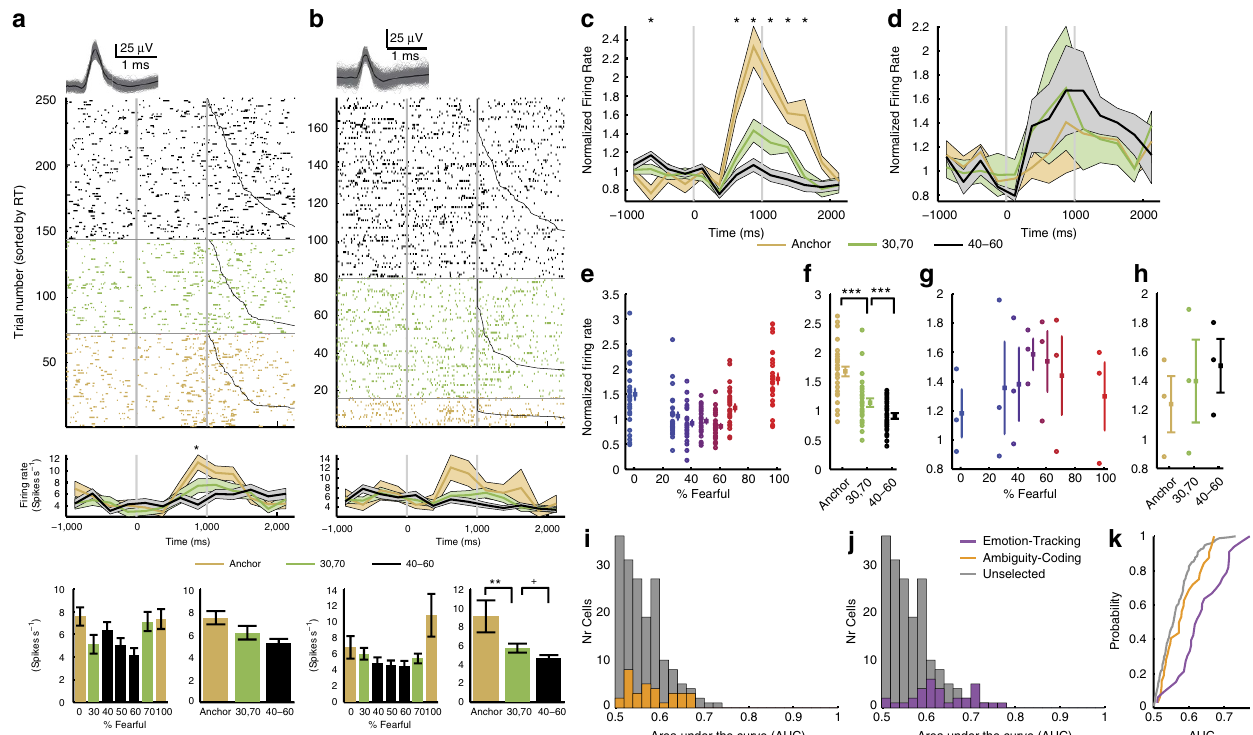
Figure 4 | Ambiguity-coding neurons. ( a , b ) Two example neurons that fire most to the anchors and least to the most ambiguous stimuli (linear regression: P o 0.05). Each raster (top), PSTH (middle) and average firing rate (bottom) is colour coded according to ambiguity levels as indicated. Trials are aligned to face stimulus onset (left grey bar, fixed 1s duration) and sorted by RT (black line). PSTH bin size is 250ms. Shaded area and error bars denote ± s.e.m. across trials. Asterisk indicates a significant difference between the conditions in that bin ( P o 0.05, one-way ANOVA, Bonferroni-corrected). Bottom left shows the average firing rate for each morph level 250- to 1,750-ms post-stimulus-onset. Bottom right shows the average firing rate for each ambiguity level 250- to 1,750-ms post-stimulus onset. Asterisks indicate significant difference between levels of ambiguity using unpaired two-tailed t -test. ** P o 0.01 and þ : P o 0.1. Waveforms for each unit are shown at the top of the raster plot. ( c , d ) Average normalized firing rate of ambiguity-coding neurons that increased ( n ¼ 29) and decreased ( n ¼ 3) their firing rate for the least ambiguous faces, respectively. Asterisk indicates a significant difference between the conditions in that bin ( P o 0.05, one-way ANOVA, Bonferroni-corrected). ( e , f ) Mean normalized firing rate at each morph level ( e ) and ambiguity level ( f ) for 29 units that increased their spike rate for less ambiguous faces. ( g , h ) Mean normalized firing rate at each morph level ( g ) and ambiguity level ( h ) for 3 units that increased their spike rate for more ambiguous faces. Normalized firing rate for each unit (left) and mean ± s.e.m. across units (right) are shown at each level. Asterisks indicate significant difference between conditions using paired two-tailed t -test. *** P o 0.001. ( i ) Histogram of AUC values for ambiguity-coding neurons (orange) and unselected neurons that are neither ambiguity coding nor emotion tracking (grey). ( j ) Histogram of AUC values for emotion-tracking neurons (purple) and unselected neurons that are neither ambiguity coding nor emotion tracking (grey). ( k ) Cumulative distribution of the AUC values. ( i – k ) Ambiguity-coding neurons did not differentiate fearful versus happy emotions with anchor faces (similar AUC values as unselected neurons) but emotion-coding neurons did (greater AUC values than unselected We refer to this group of cells as ambiguity-coding neurons. Neurons with higher firing rate for less ambiguous faces had a U-shaped response curve as a function of morph levels (Fig. 4c,e) and thus decreasing levels of activity as a function of ambiguity levels (Fig. 4f). The difference between anchor versus intermediate ambiguous faces (mean normalized firing rate: 0.53 ± 0.44; mean ± s.d.) was greater than that between inter- mediate versus the most ambiguous faces (0.23 ± 0.24; paired t -test: t (28) ¼ 2.96, P ¼ 0.0062, g ¼ 0.86; Fig. 4c,f), indicating a sharper transition from anchor face to ambiguity. In contrast, neurons with higher firing rate for more ambiguous faces had inverted U-shaped response curves as a function of morph levels (Fig. 4d,g) and thus increasing the levels of activity as a function of ambiguity levels (Fig. 4h). Since most ambiguity-coding neurons responded least to high ambiguity but most to unambiguous anchor faces ( w 2 -test: P o 10 (cid:3) 10 ; Fig. 4e–h), the overall population response ( n ¼ 32) was, as expected, maximal for the least ambiguous faces.